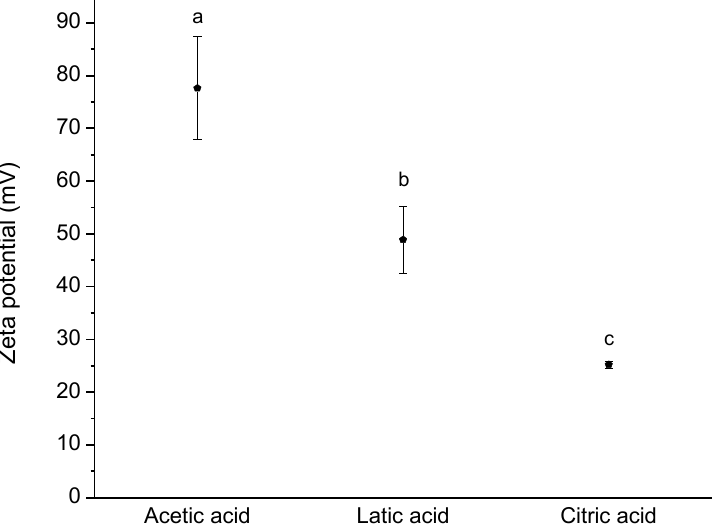
Figure 2. Zeta potential of chitosan solutions (0.5% ( w / w )) dissolved using acetic acid at different pH’s. Data points with different letters are significantly different ( p < 0.05) from each other. The error bars consist of the standard deviation calculated with the data obtained from three runs of triplicate.